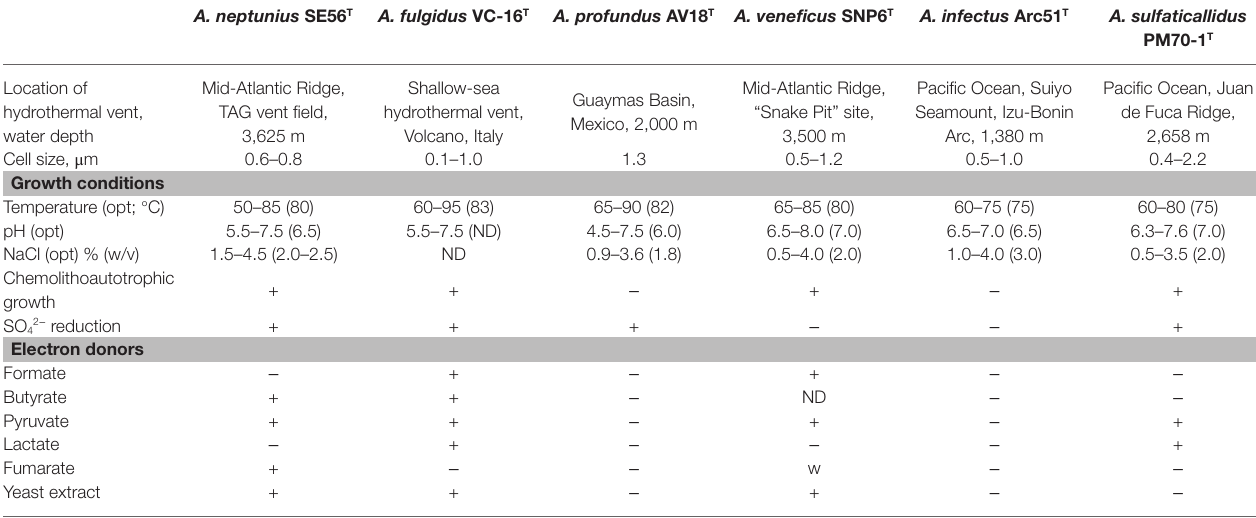
TABLE 1 | Differential characteristics of strain SE56 T and the type stains of the species of the genus Archaeoglobus